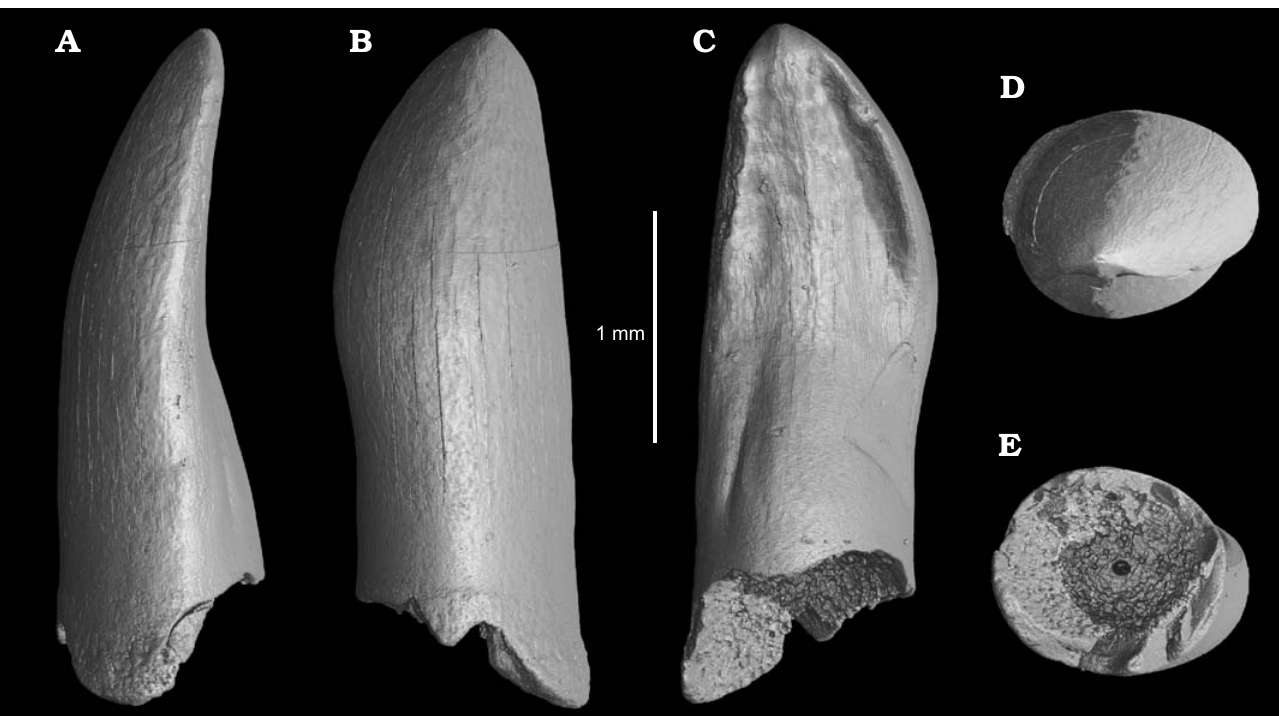
Fig. 2. Isolated tooth (CHVm03.588) of an indeterminate embryonic or hatchling sauropod from the Berriasian (Early Cretaceous) of Cherves-de-Cognac, France; in mesial ( A ), labial ( B ), lingual ( C ), apical ( D ), and basal ( E )